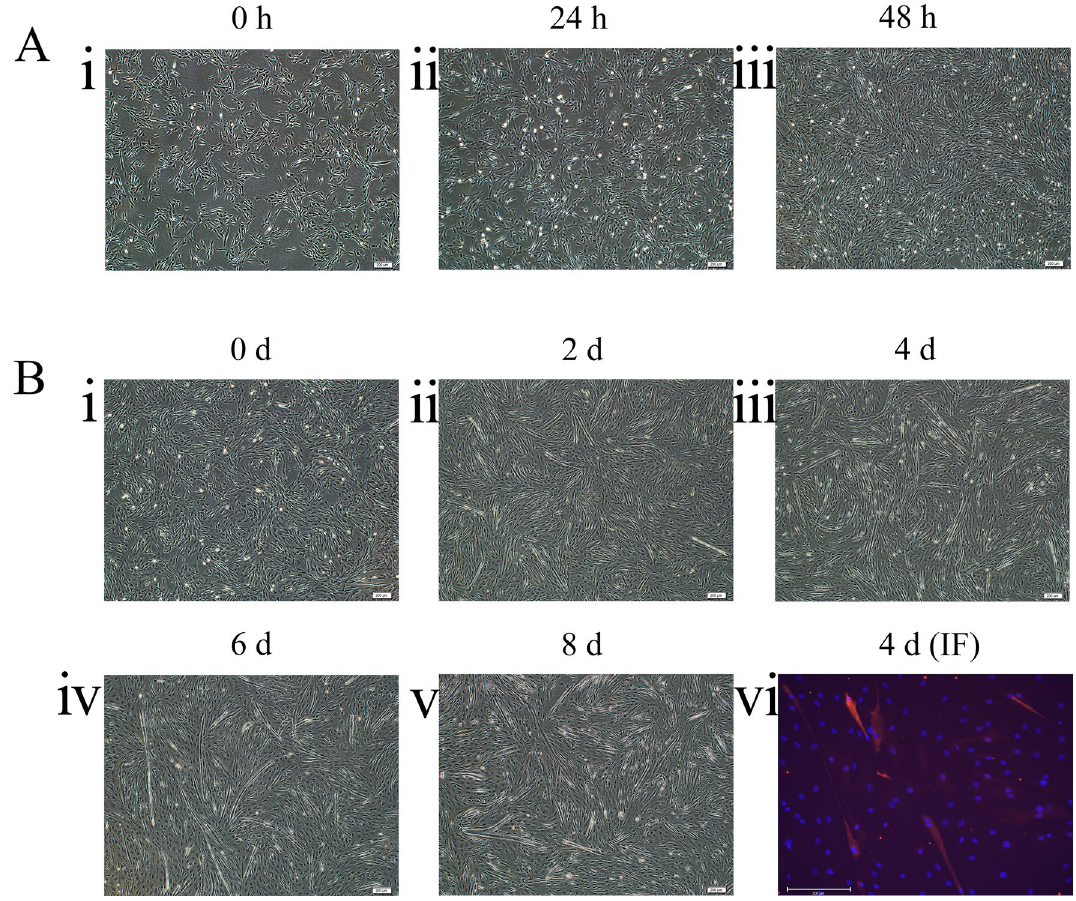
vi) immunofluorescence, DAPI staining is shown in blue and MYHC is shown in red (100